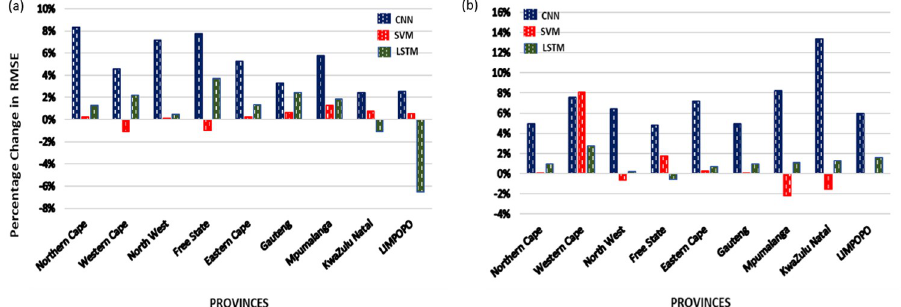
Fig 7. Percentage change in performance of each ML method for predictions in Experiment III. (a) & (b): Percentage change in performance of each ML method over each province when predictions were made with the parameters from REVAC tuning instead of the grid-search parameters for (a) upward augmented data and (b) downward augmented data-set. High percentage RMSE indicates an improvement in task performance and vice-versa.